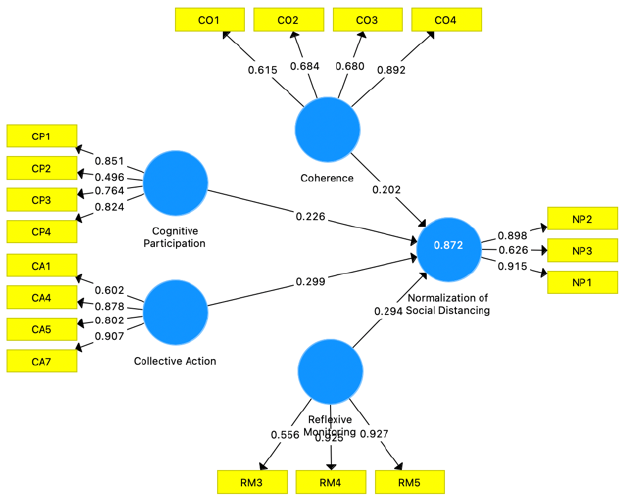
Figure A4. Model Generated on the Third Iteration after Removing CA2, CA3, CA6, and RM2.